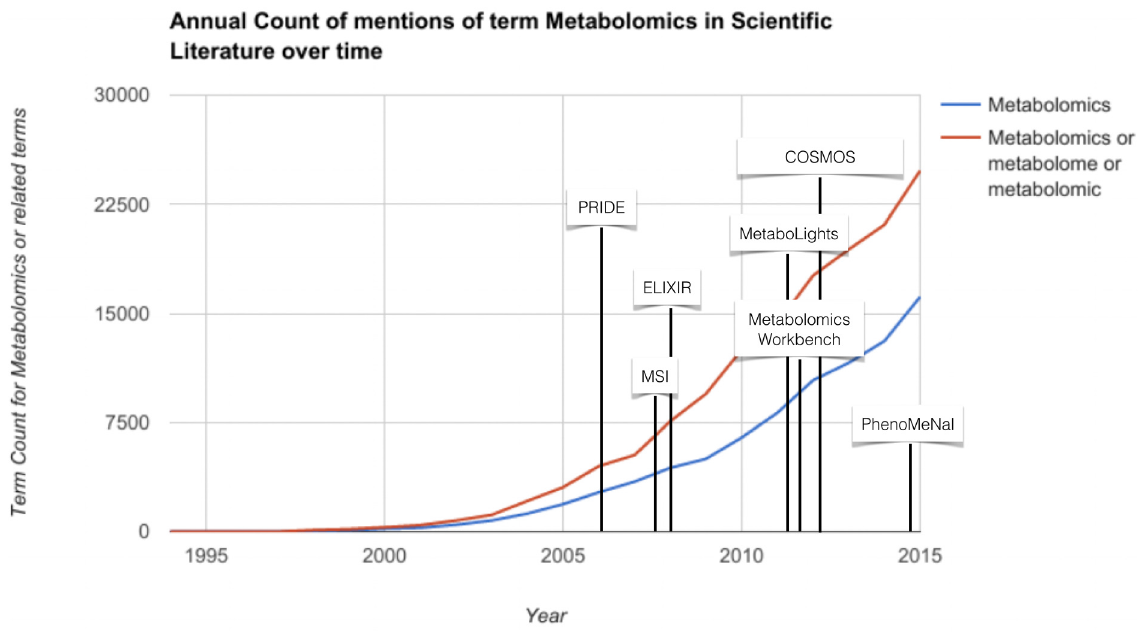
Figure 1. Annual count of mentions of the term ‘metabolomics’ (and related terms) in the literature over time, annotated with important milestones in data sharing and standards in metabolomics. Source: Data from Google